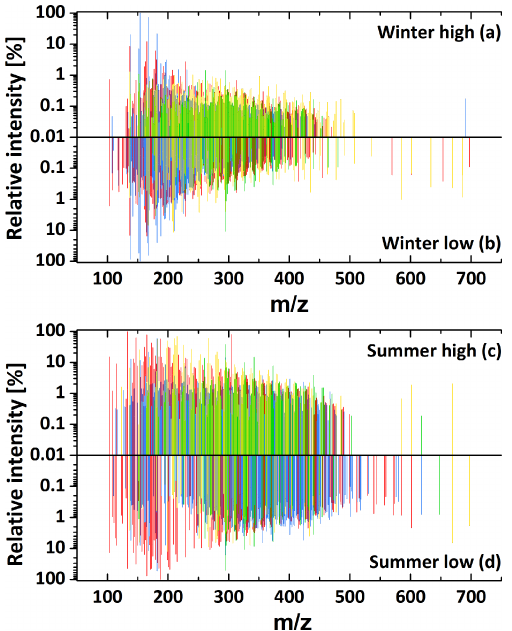
Figure 1. Negative-ionisation mass spectra for the four composite samples WH (a) , WL (b) , SH (c) and SL (d) . Colour-coding dif- ferentiated formulae with differing molecular compositions: CHO (red), CHON (blue), CHOS (yellow) and CHONS